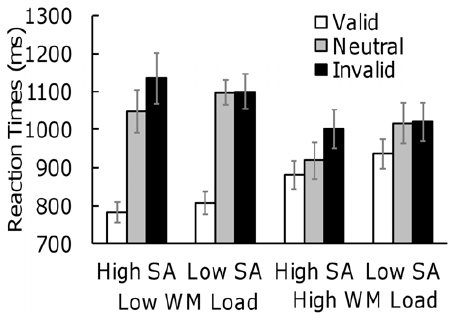
Figure 3. Mean correct RTs (ms) in high and low socially anxious individuals in a visual search task. Note. Error bars represent standard errors. SA=Social Anxiety; WM=Working Memory. doi:10.1371/journal.pone.0047221.g003 PLOS ONE |